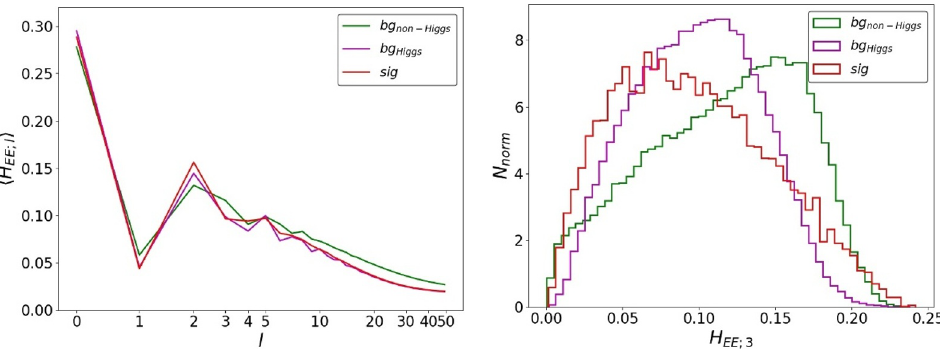
Figure 17 . FW spectra of h H EE ; l i (left) and event distributions of H EE ;3 (right) for the (cid:23)(cid:23)h h and its background samples after preselection.